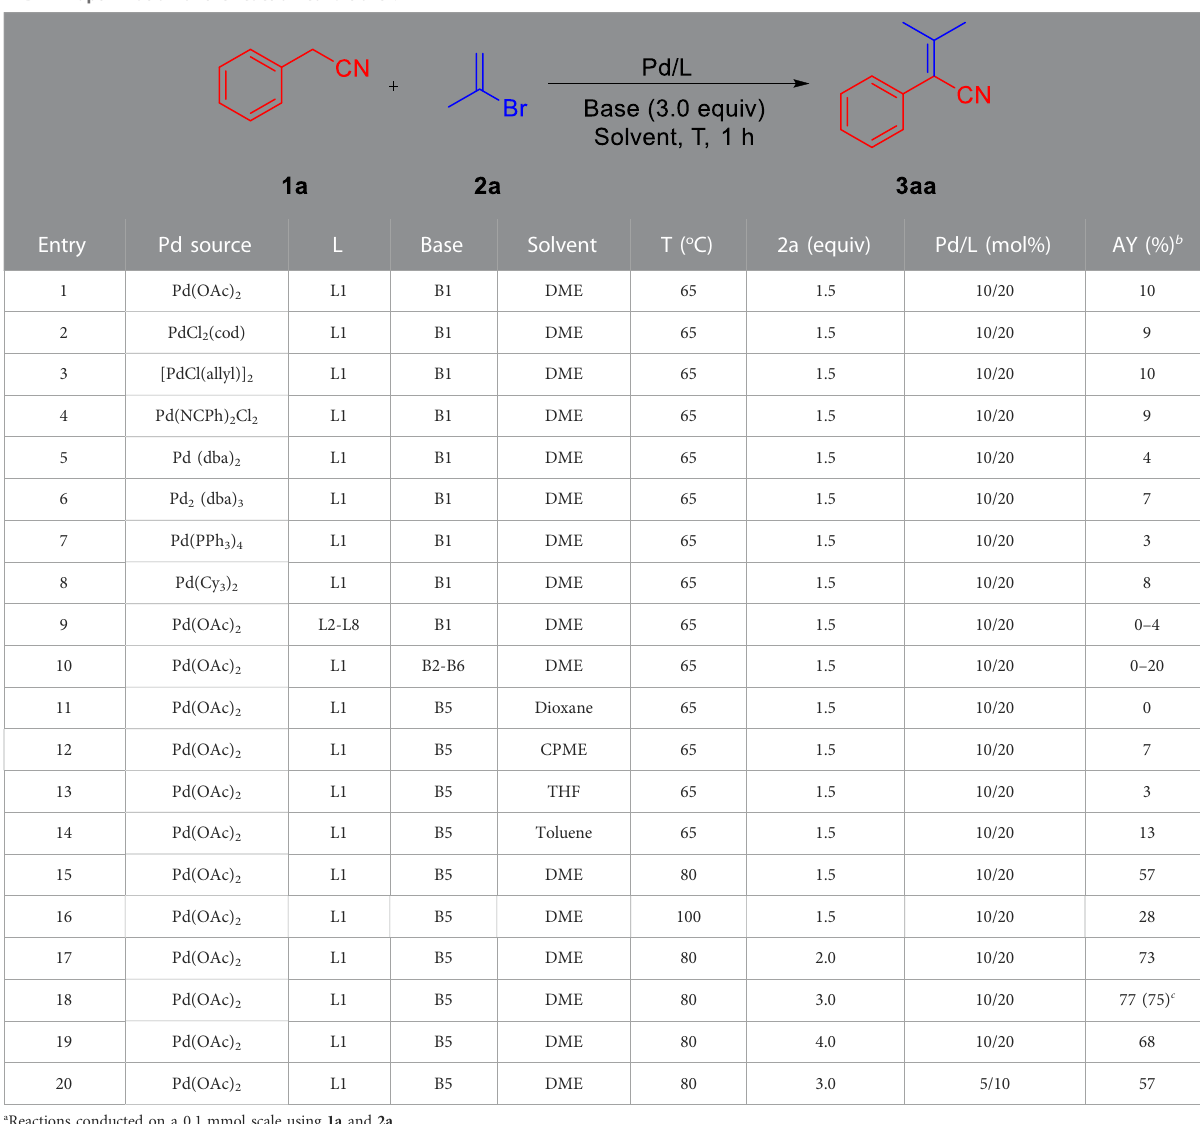
TABLE 1 Optimization of the reaction conditions a